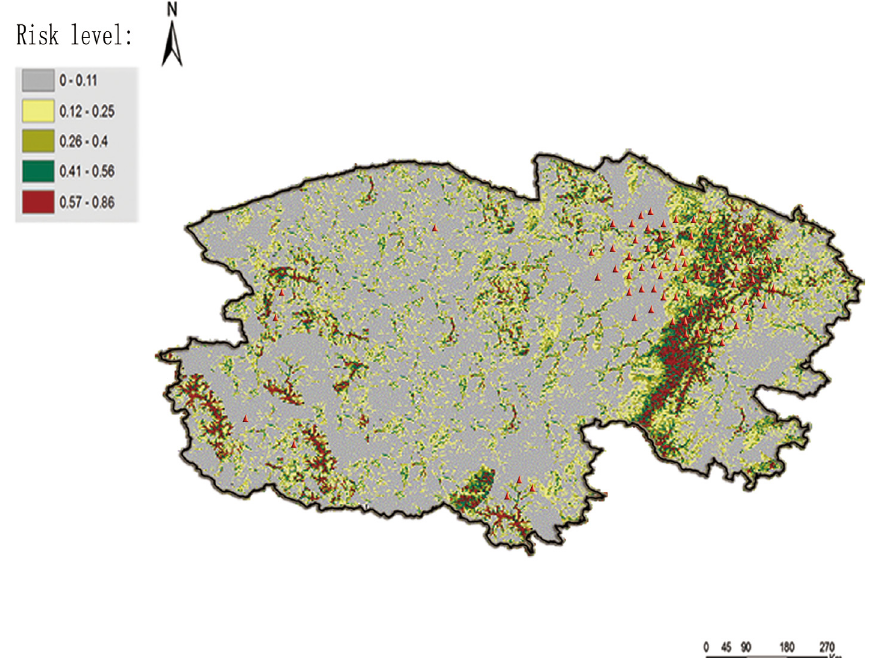
Figure 3. Risk map of F. hepatica infestation predicted by MaxEnt. The highest risk of infestation with F. hepatica is situated in the east of Qinghai province. The red triangles represent the location of sheep herds considered positive for F. hepatica